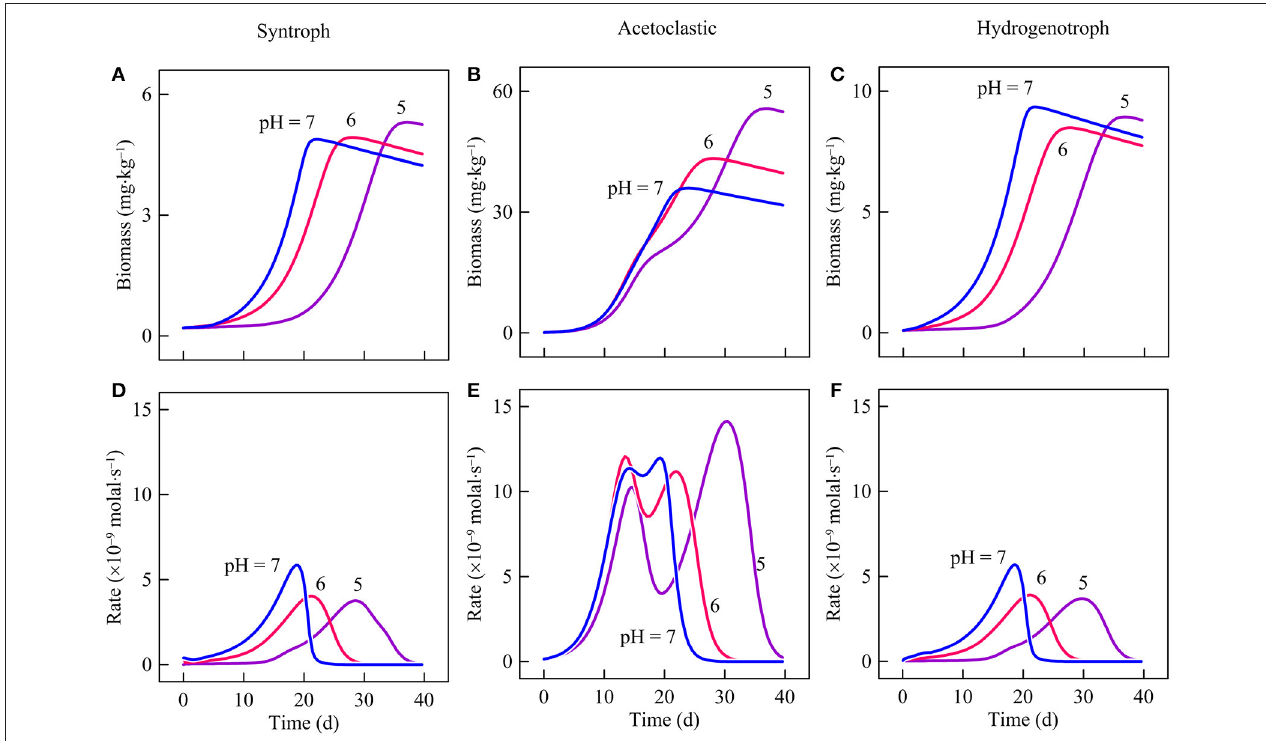
FIGURE 6 | Variation with time in the biomass concentrations and respiration rates of strain IB (A,D) , Methanosarcina mazei (B,E) , and Methanobacterium formicium (C,F) in batch reactors of differ pHs. Lines are the results of biogeochemical reaction modeling, accounting for the impact of pH on the energy available from microbial